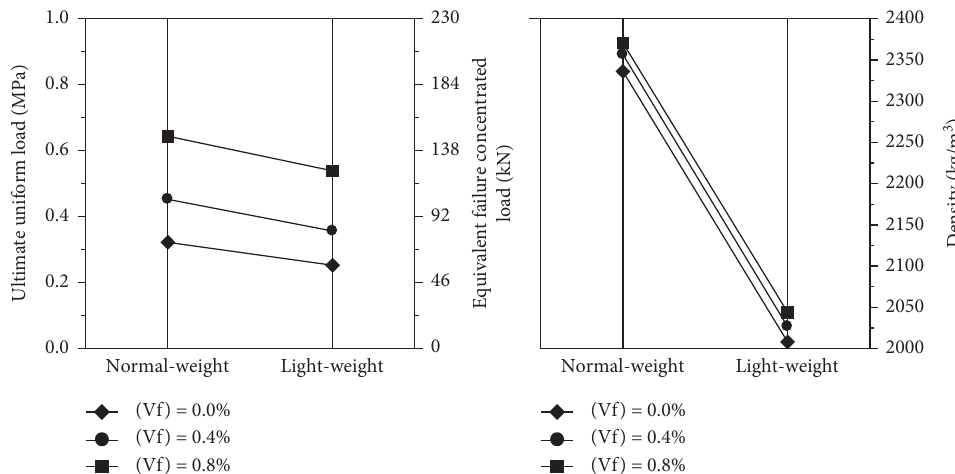
Figure 8: Effect of replacing normal-weight aggregate by lightweight aggregate on ultimate uniform load and